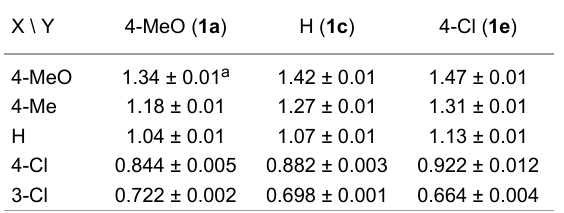
Table 4: The DKIEs ( k H / k D ) of the reactions of Y-aryl phenyl isothio- cyanophosphates with XC 6 H 4 NH(D) 2 in MeCN at 55.0